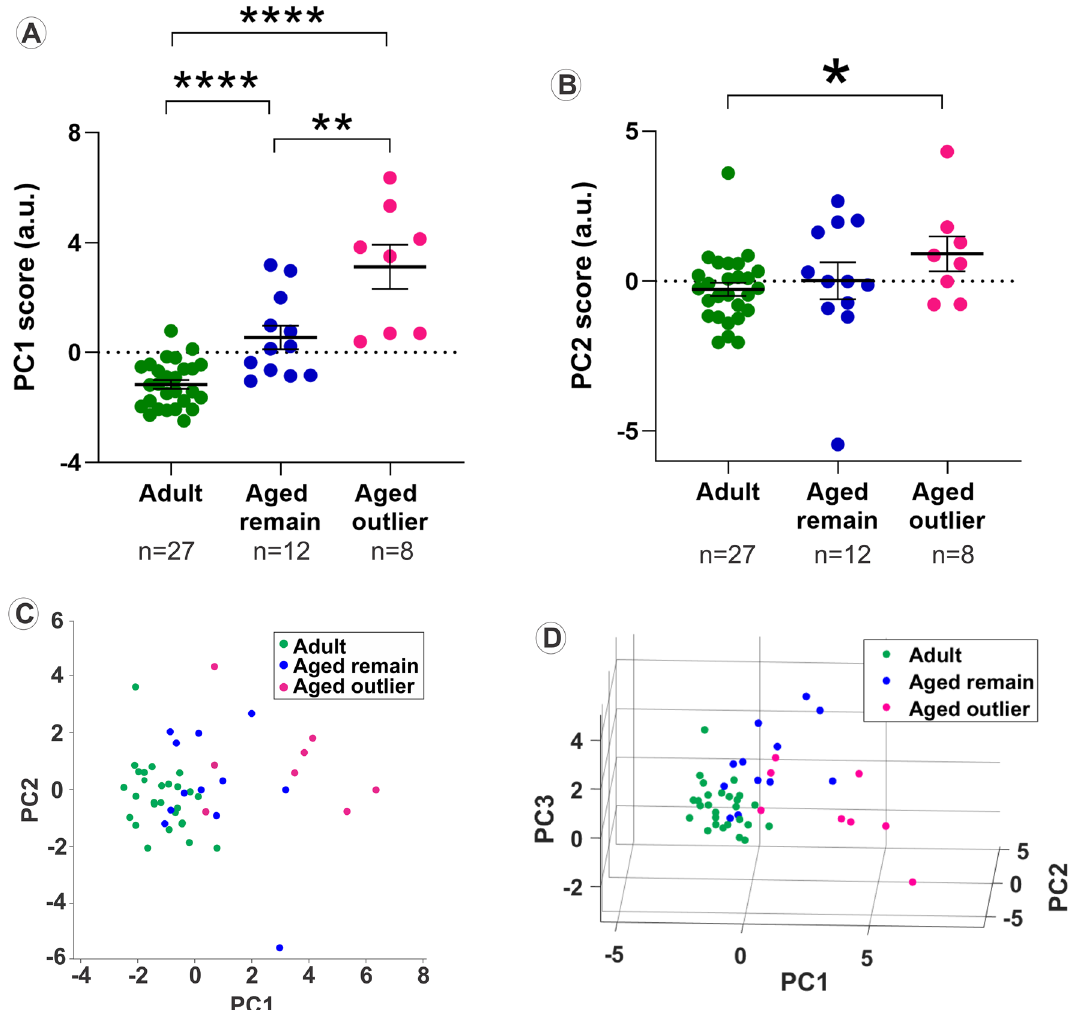
Figure 4. Principal component analysis. PC1 scores were significantly higher in aged outliers compared to both aged remain ( p < 0.01) and adult ( p < 0.0001) groups, and the PC1 score was also higher in aged remain compared to adults ( p < 0.0001) ( A ). PC2 scores were significantly higher between aged outliers and adults ( p < 0.05), and no differences in PC2 scores were detected between the aged remain group and adults or aged outliers ( B ). 2D-distrubtion plot of PC1 and PC2 scores showed separation of experimental groups with the majority of adult and aged remain animals forming a cluster and the majority of aged outliers forming a separate cluster ( C ). The addition of PC3 scores to provide a 3D-distribution plot to suggest separation of adults and aged outliers also in the third dimension ( D ). Data plots are presented as mean ± SE, and statistics are shown as * indicating p < 0.05, ** indicating p < 0.01, and **** indicating p < 0.0001 between Weights were 8.0 ± 0.3 (n = 27), 8.8 ± 0.6 (n = 12), and 9.3 ± 0.7 (n = 8) for the adult, aged remain, and aged outlier cohorts, respectively, and not statistically different between groups. In addition, BCS was 2.98 ± 0.10 (n = 27), 3.30 ± 0.18 (n = 12), and 3.25 ± 0.25 (n = 8) for the adult, aged remain, and aged outlier cohorts, respectively, and not statistically different between groups. Correlation matrix for demographic, urodynamic, and metabolic outcomes. Pairwise correla- tions were next performed between multiple demographic, urodynamic and laboratory markers, including age, weight, IV25, Bcomp, Capacity-IV25, glucose, ALT, AST AST/ALT, LDH, Cholesterol, Triglycerides, and hsCRP for the Adult, Adult remain, and Aged outlier groups (Fig. 6). A heat map display suggested an increased number of pairs with a strong correlation between individual outcome measures for the aged outliers (Fig. 6C) compared to the adult and aged remain groups (Fig. 6A,B). The heat map display included several unique pairs of data indi- cating strong correlations between weight, bladder capacity and compliance, and metabolic markers for the aged outlier group (Fig. 6C). Next, we determined how weight, triglyceride, and Capacity-IV25 were correlated to each other and to IV25, Bcomp, cholesterol, AST/ALT, and hsCRP. A correlation of 0.50 or higher in either direc- tion was considered to indicate a strong association between pairs. A strong correlation was detected between weight and Capacity-IV25 in both Aged remain and Aged outlier groups, whereas a strong correlation between